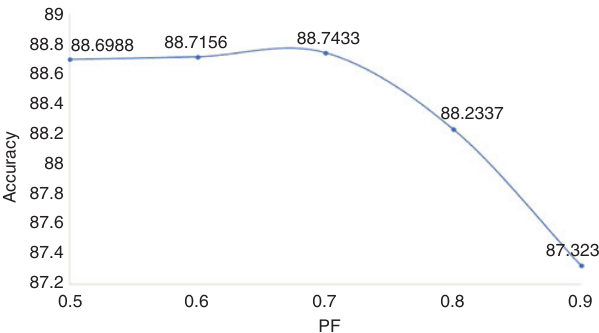
Figure 4: Effect of TP on Accuracy: SSO (Vowel Data